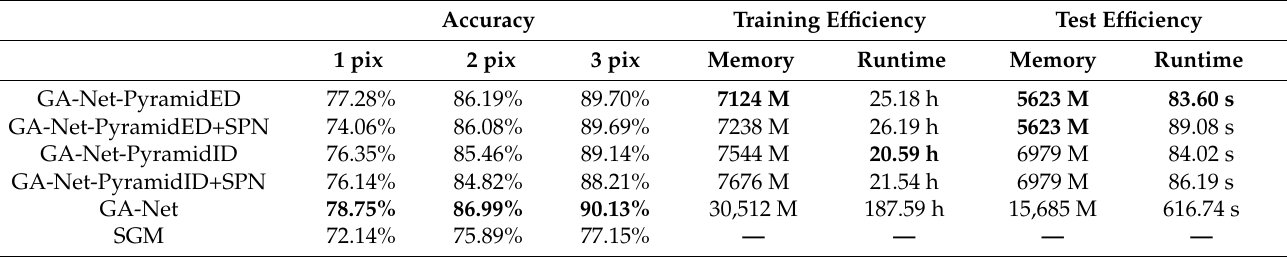
Table 3. Accuracy and efficiency comparison between GA-Net-Pyramid, including